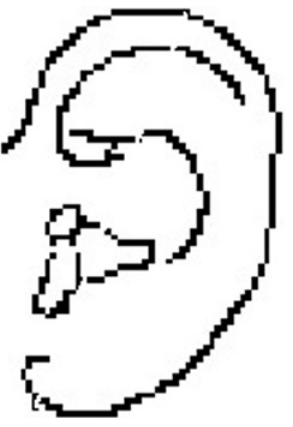
Figure 4: Outer Edge of Ear